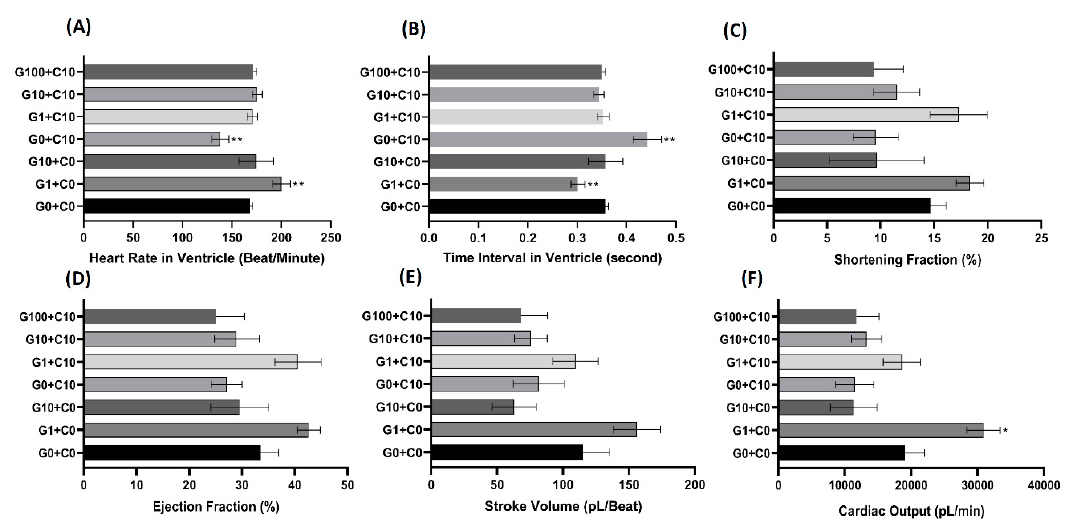
Figure 4. Results for heartbeat rate, heartbeat interval, shortening fraction, ejection fraction, stroke volume, and cardiac output in zebrafish embryos after treatment with GHK tripeptide and copper combinations. Zebrafish embryos aged 24 hpf were treated with GHK tripeptide and copper combinations for 48 h continuously, and the cardiac-related endpoints were measured: ( A ) heartbeat rate, ( B ) heartbeat interval, ( C ) shortening fraction, ( D ) ejection fraction, ( E ) stroke volume, and ( F ) cardiac output in the ventricle. G = GHK (nM), C = CuSO 4 (nM). G0 + C0 was used as a control group. G1 + C0 and G10 + C0 were used as GHK function test groups. G0 + C10 was used as a cardiotoxicity